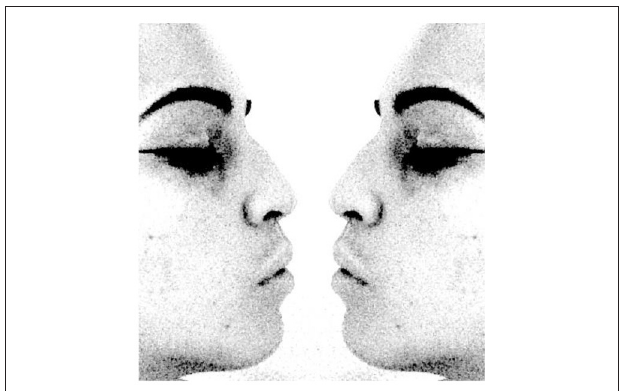
FIGURE 5 | The lightness illusion (https://www.wikiwand.com/en/ Optical_illusion#/google_vignette--Retrieved 2 September 2021).